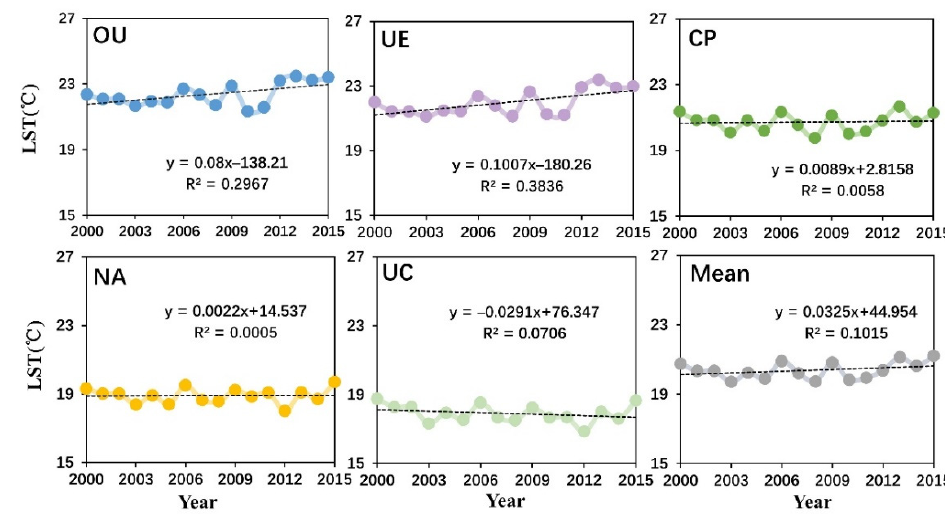
Figure 14. The trend of land surface temperature (LST) of different land use types in the influence area of the YRB from 2000 to 2015.